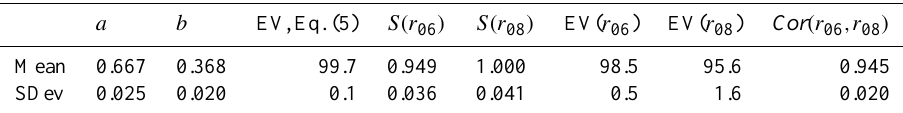
Table 2. Annually averaged parameters (Mean) and their standard deviation (SDev) obtained by the downscaling algorithm. This includes: the slopes a and b of Eq. (5), and the explained variance EV (Eq. 5) of the underlying linear equation; the slopes S(r 06 ) and S(r 08 ) used to scale high-frequency variations in the HRV channel to estimate unresolved variability in the 0.6 and 0.8µm reflectance (based on Eq. B6); the explained variance EV( r 06 ), EV( r 08 ) of these estimates; and the correlation coefficient between variations in the 0.6 and 0.8 µm reflectance. Explained variances (EV) are listed in units of percent.